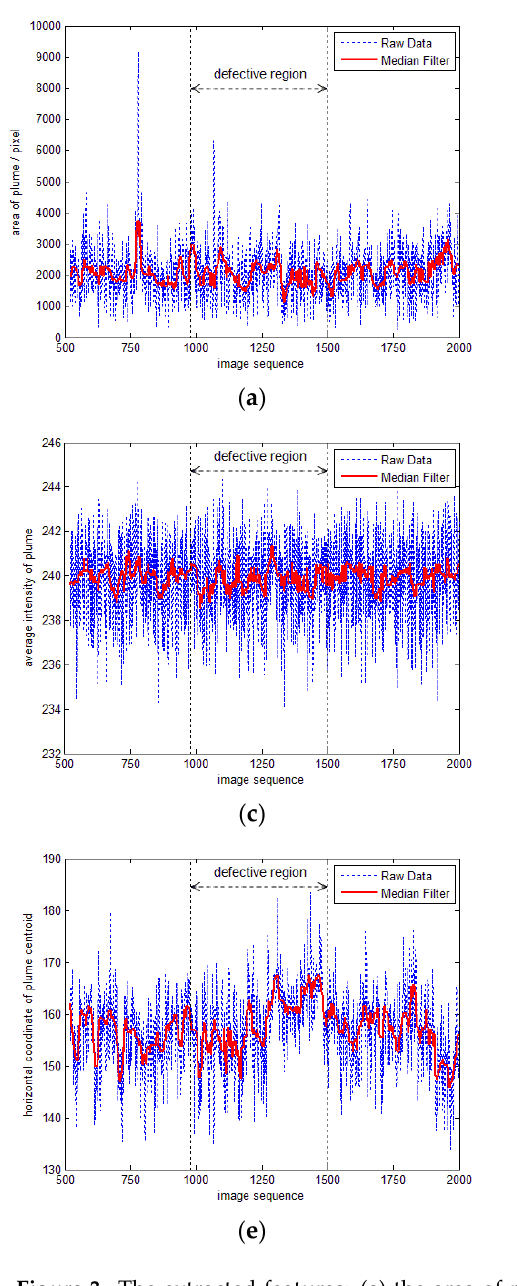
Figure 3. The extracted features: ( a ) the area of metal vapor plume; ( b ) the height of metal vapor plume; ( c ) the average intensity of metal vapor plume; ( d ) the vertical coordinate of plume centroid; ( e ) the horizontal coordinate of plume centroid; ( f ) the number of spatters.